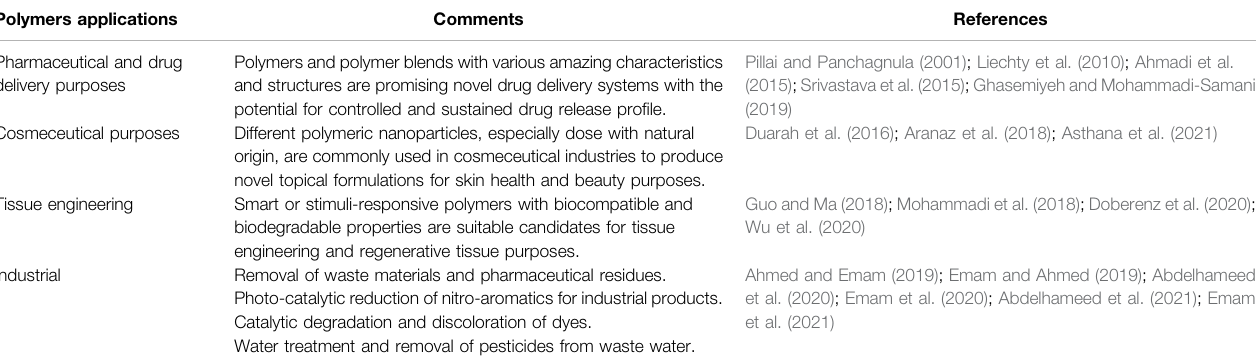
TABLE 1 | Different applications of polymers and polymeric